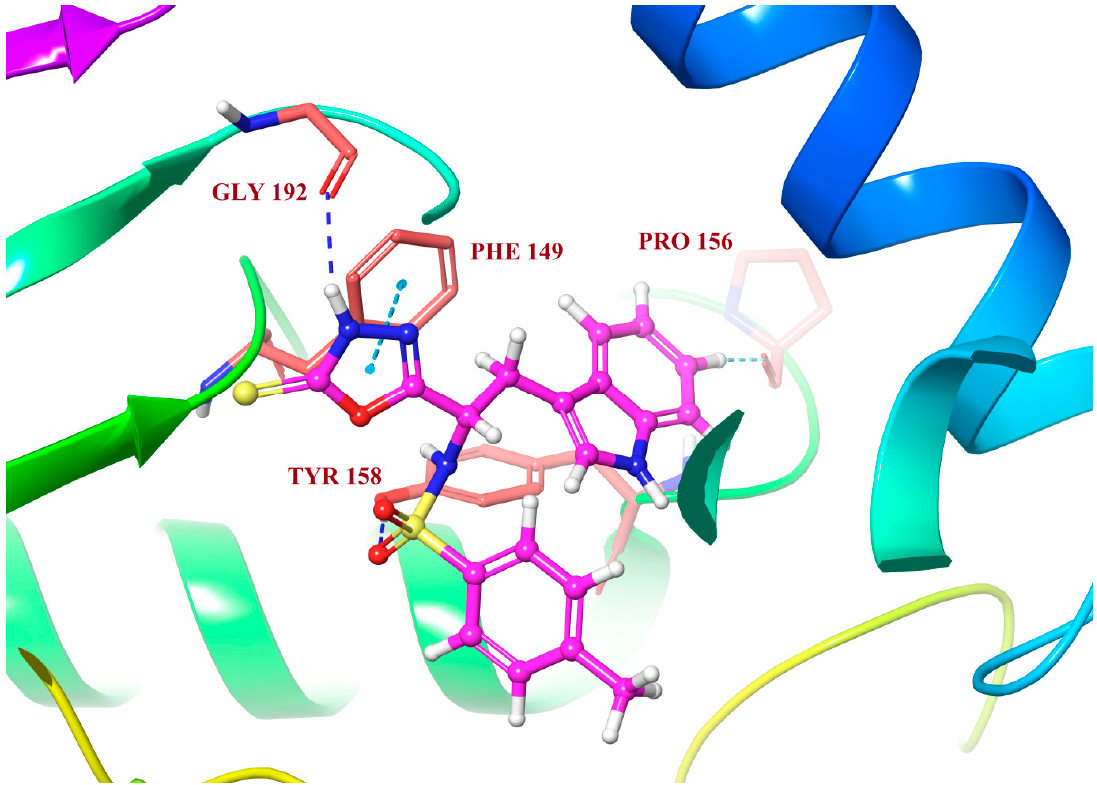
Figure 1. Dockingpose of the title compound 2 against mycobacterial enoyl reductase (InhA).